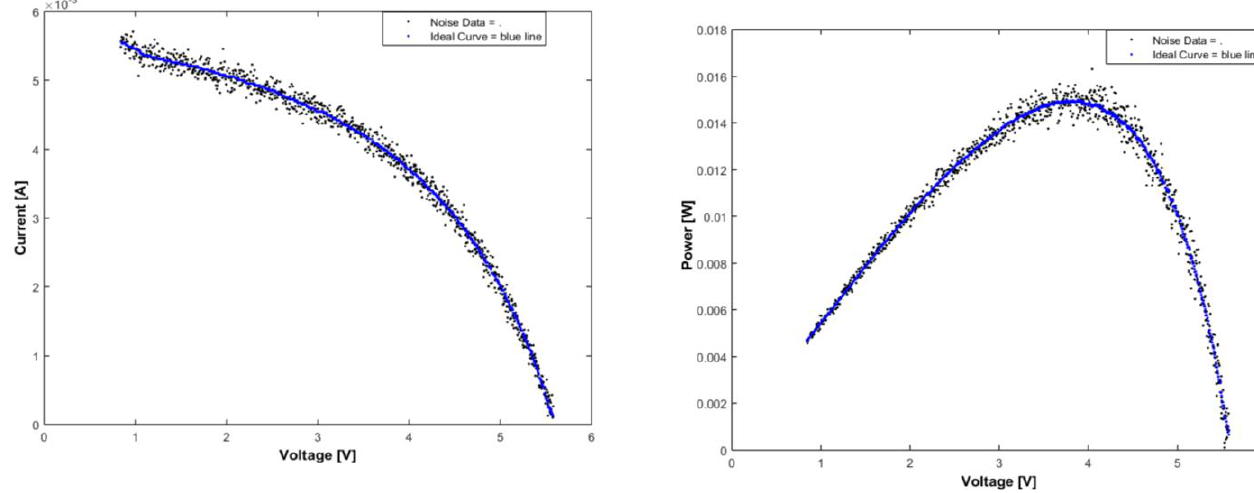
Figure 9 . P-V curve with noise measured